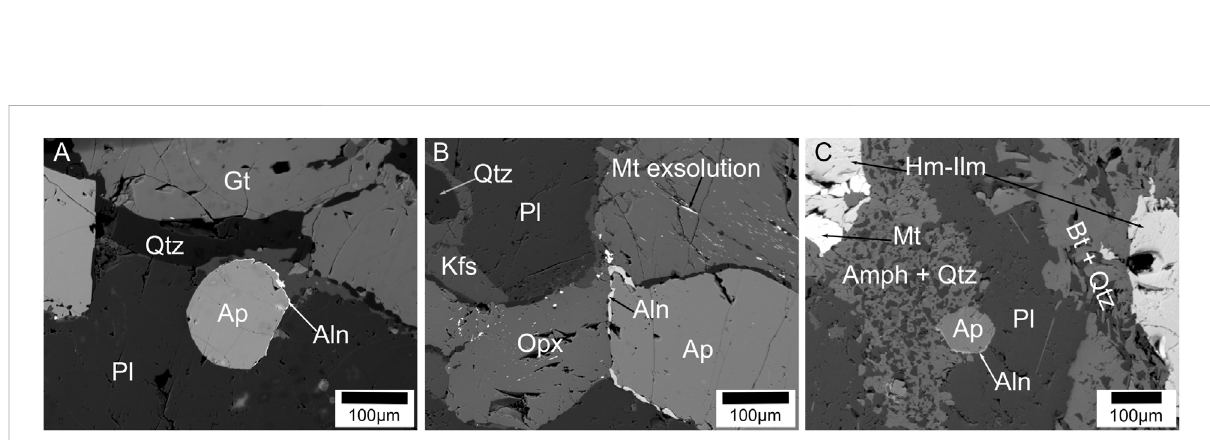
Back scattered electron images of mineral assemblages in equilibrium and their textures in metagabbro samples. Apatite grains (with no monazite blebs) (A,D) within garnet; (B) within clinopyroxene; (C) on garnet, plagioclase, quartz grain boundary; (E) along a magnetite-apatite vein passing through plagioclase; (F) on the orthopyroxene grain boundary.